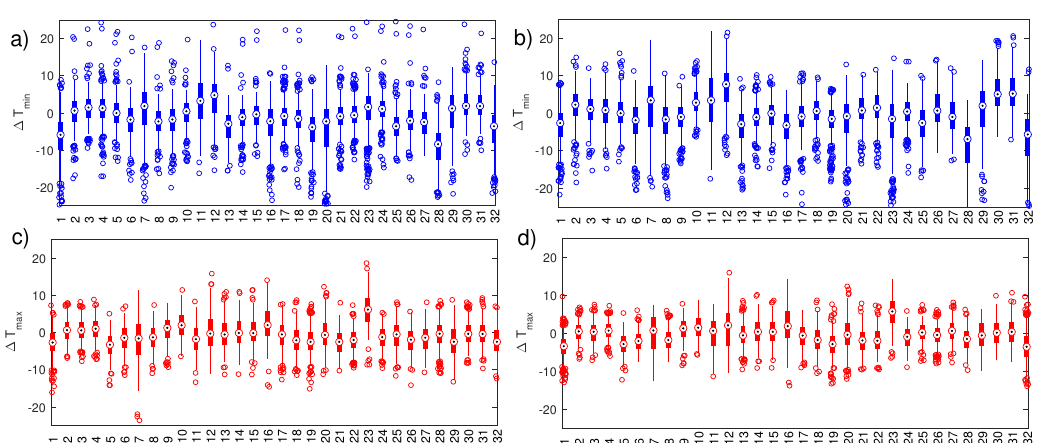
Figure 2. Recurrence analysis at three specific grid points. Lines represent the curve ( (cid:96) , τ ) . ( a ) grid point in central Europe with small inter-model biases, ( b ) grid point in northern Europe with large inter-model biases for cold temperature extremes, ( c ) grid point in southern Europe withEMM biases for hot temperature extremes and small inter-model biases . Red line: 20 CRv2c, black dashed line: EMM and SDM (errorbars), Grey lines: single models.